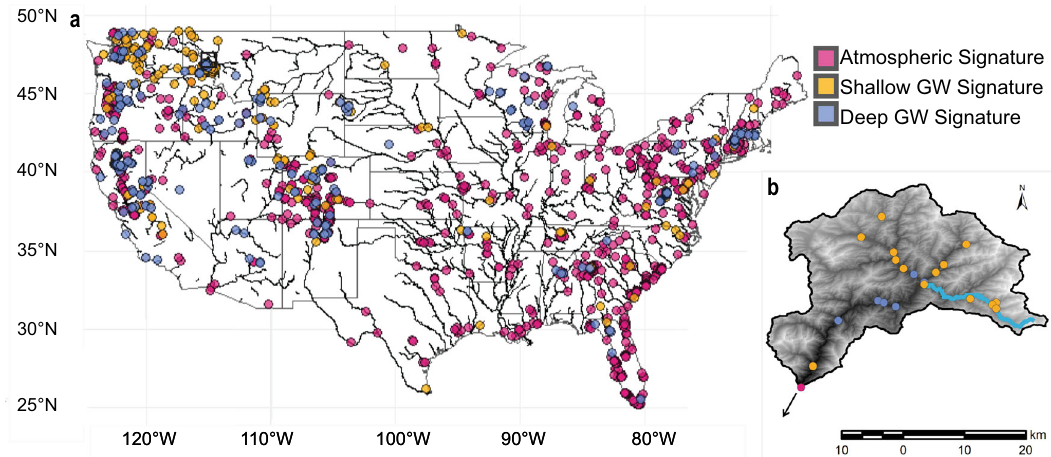
Fig. 1 Spatial distribution of stream sites by categorical groundwater signature. Categorical groundwater (GW) signatures derived from annual paired air – stream water temperature signals a across the continental United States and b within a single watershed, the North Fork of the Clearwater River-Lake Creek watershed, Idaho — Montana, USA (Hydrologic Unit Code HUC10 – 1706030701). Lake Creek stream is highlighted. Across the United States, counts of each category are atmospheric signature (pink) n = 868; shallow groundwater GW signature (yellow) n = 292; deep groundwater GW signature (blue) n = 264. Legend descriptions are maintained between a and b . Base map a was generated from R package ‘ maps ’ version 3.3.0 and the Nation Hydrography Dataset 70 b was created from 7.5-minute ground surface elevation data courtesy of the U.S. Geological Survey.